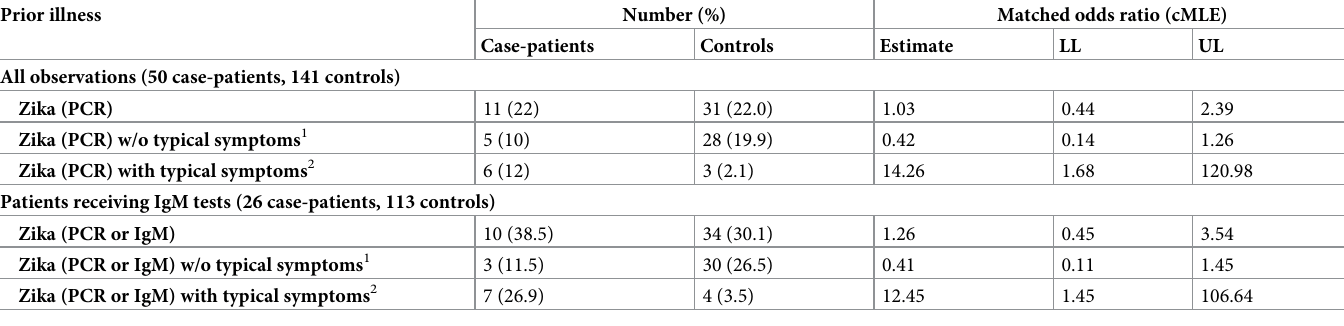
Table 5. Association between prior illness and GBS for 50 GBS case-patients and 141 matched controls–laboratory tests. Prior illness